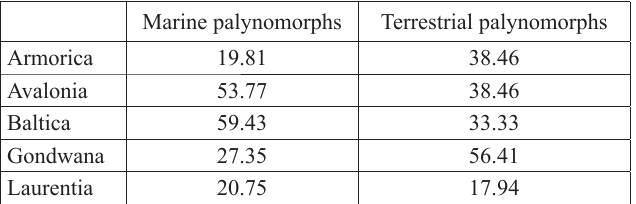
Table 1. Marine and terrestrial taxa (in %) from the Los Espejos For- mation (Precordillera Argentina) also present in coeval palaeoplates worldwide and in other Gondwanan